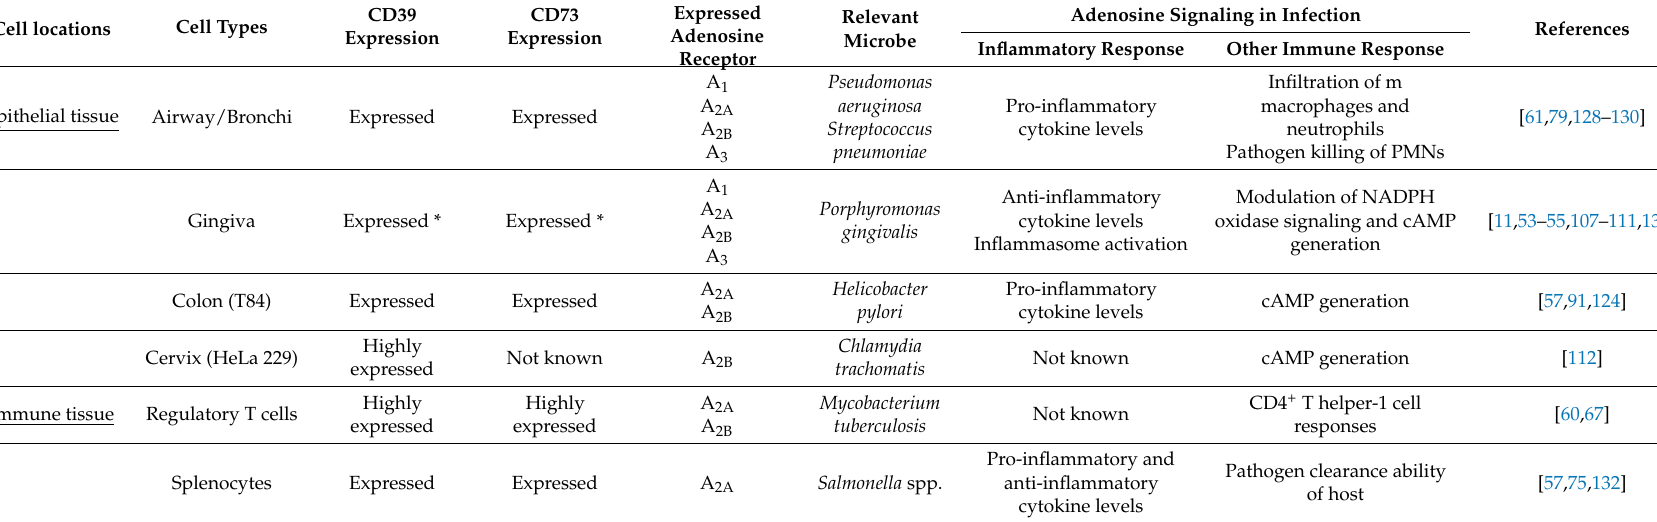
Table 1. Overview of examples of different cell types reported to: (1) express CD39, CD73, and/or adenosine receptors; and (2) have association with microbial infection. Based on the up-to-date literature, notable changes in inflammatory responses as well as innate and/or adaptive immune responses that occur by altered adenosine signaling during infection are also summarized. Nicotinamide adenine dinucleotide phosphate-oxidase (NADPH oxidase); Cyclic AMP